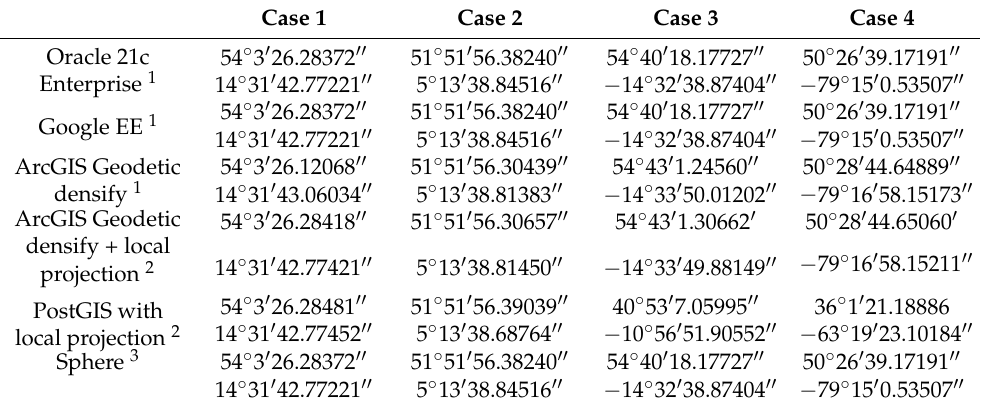
Table 1. Point coordinates (latitude and longitude, in degrees) of the geodetic intersections